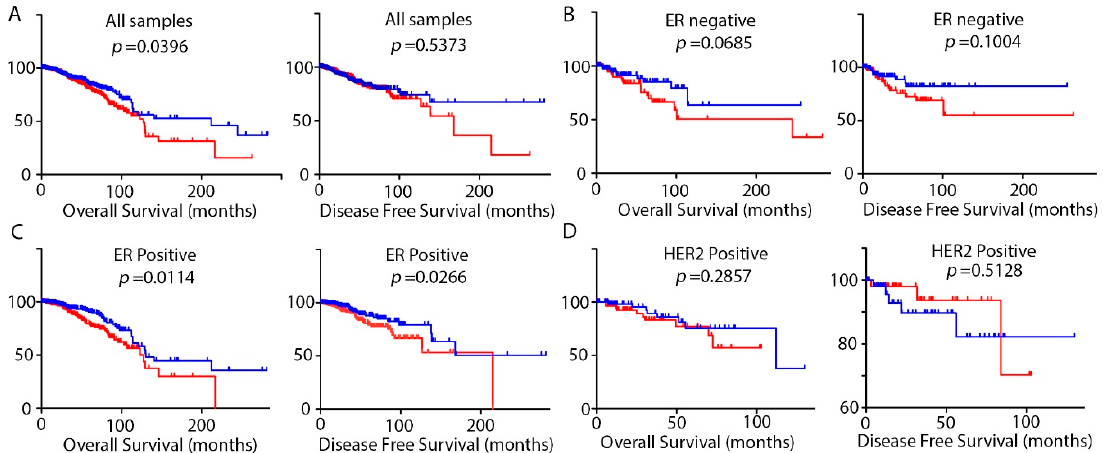
Figure 3. Overall survival or disease-free survival determined by Kaplan–Meier plots and the log-rank test according to DRAIC expression. The patients were divided as DRAIC high (red) or DRAIC low (blue) according to the median value of DRAIC expression. Kaplan–Meier plots were created using GraphPad Prism 5 software using data for all samples ( A ) or only ER negative patients ( B ), ER positive patients ( C ), and HER2 positive patients ( D ). Log-rank tests were used to calculate the differences between groups.